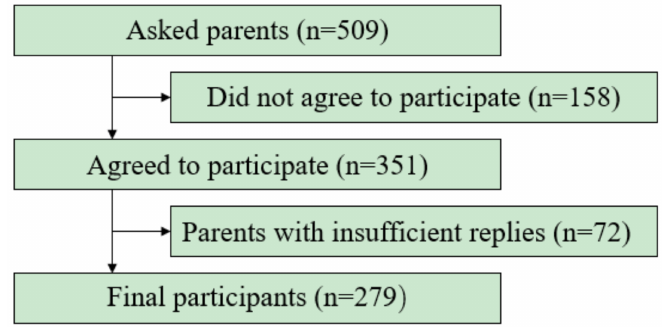
Figure 1. Chart of participant flow during the study.